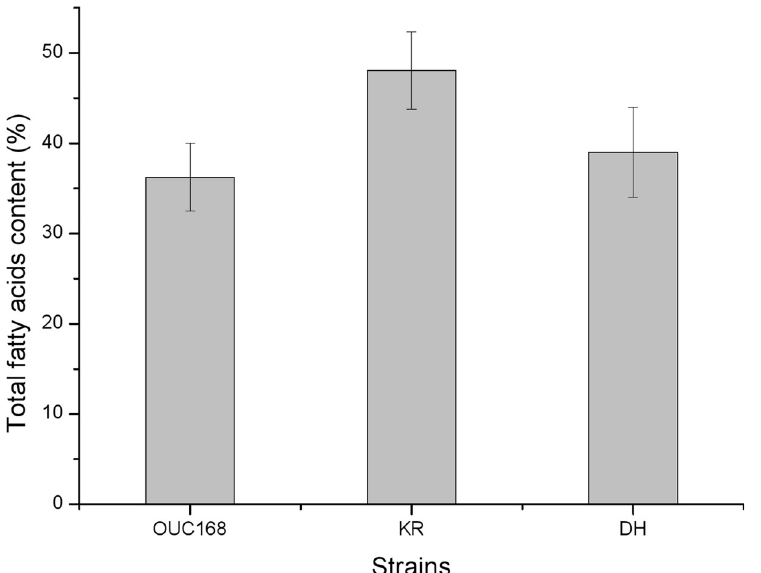
Fig 8. Total fatty acids content result of strains. All data are expressed as means ± SD (n =